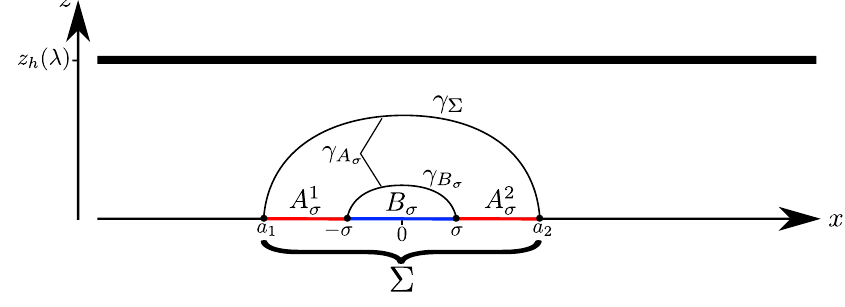
Figure 2 . A constant time slice of the black string geometry (2.1). The asymptotic boundary of this geometry | where the CFT is de(cid:12)ned | corresponds to the x -axis. The location of the black string is z = z h and depends on the energy density (cid:21) via (2.2). If (cid:27) is su(cid:14)ciently small the RT surface (cid:13) A of the entangling region A (cid:27) = A 1 A 2 (red) is the union of the RT surfaces (cid:13) (cid:6) of (cid:27) (cid:27) (cid:27) (cid:6) = A (cid:27) B (cid:27) and (cid:13) B of B (cid:27) (blue). This implies (cid:27)